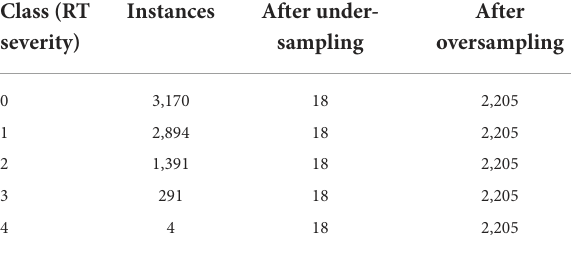
TABLE 2 Imbalanced data